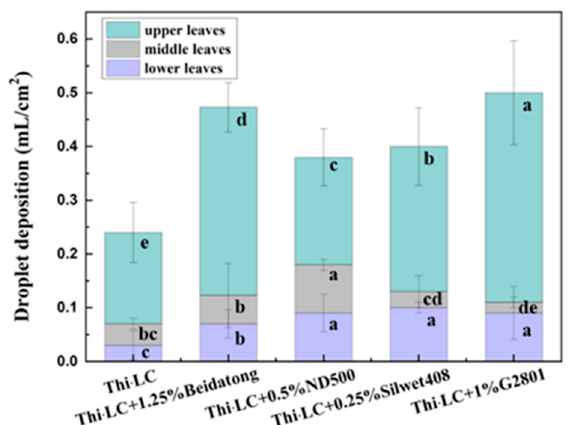
Figure 8. Pesticide droplet deposition and distribution in upper, middle, and lower wheat leaves. Lowercase letters in the histogram indicate significant differences in the data between other treatments at p < 0.05 using one-way ANOVA.